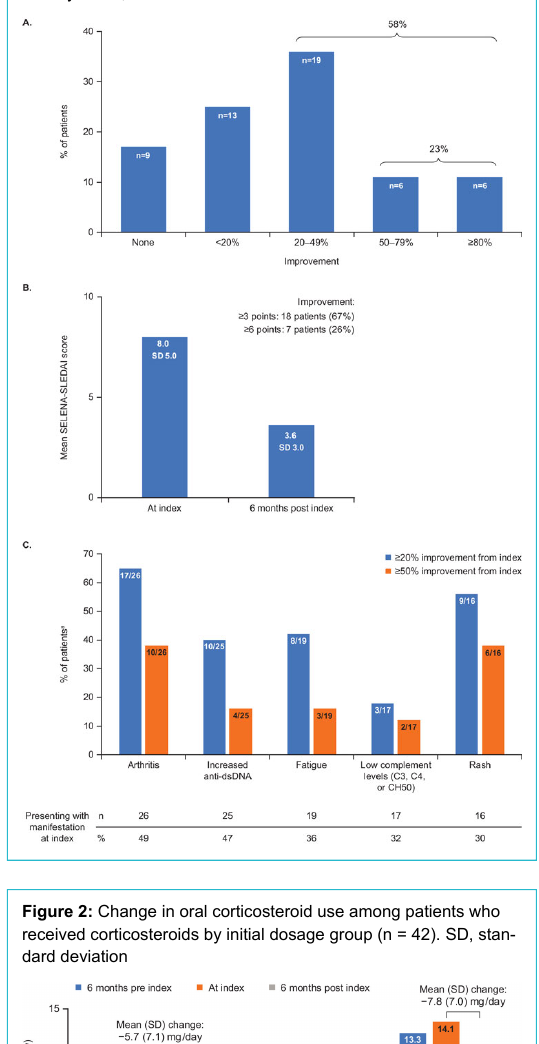
Figure 1: Clinical outcomes. (A) Physicians’ evaluation of overall clinical response at six months post index ( n = 53). (B) Change in SELENA-SLEDAI score (n = 27). (C) Physician-assessed improve- ment from index in clinical manifestations and biomarkers at six months post index ( n = 53). a Calculated based on the number of patients presenting the manifestation at index dsDNA, double- stranded deoxyribonucleic acid. SELENA-SLEDAI: Safety of Estro- gens in Lupus Erythematosus National Assessment-SLE Disease